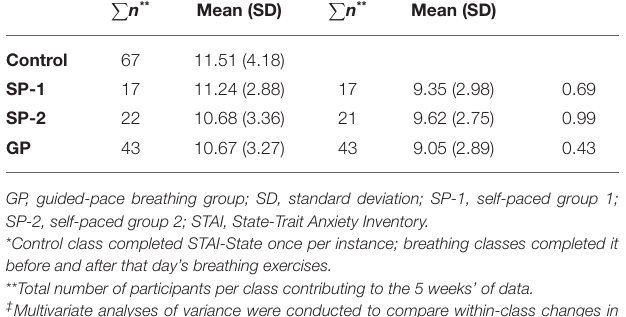
TABLE 4A | 5-week mean (SD) STAI-State scores immediately before vs. immediately after breathing exercises, by class * . Class